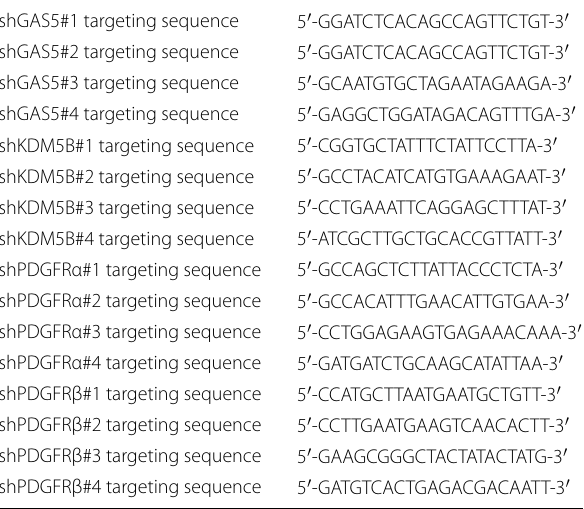
Table 1 Sequences for shRNAs shGAS5#1 targeting sequence